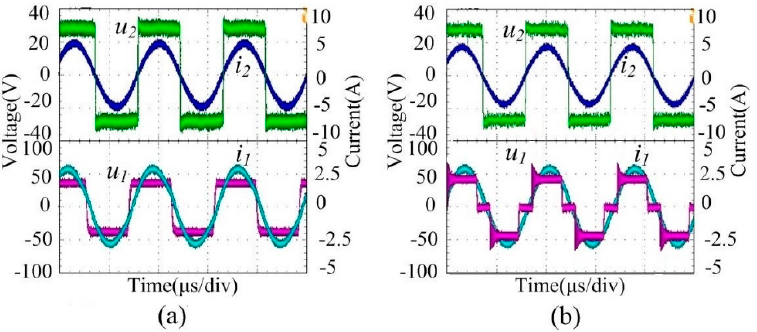
Figure 14. Experimental waveforms of u 1 , i 1 , u 2 , i 2 ( a ) U bus = 40 V & α = 0° and ( b ) U bus = 40 V & α = 45°.